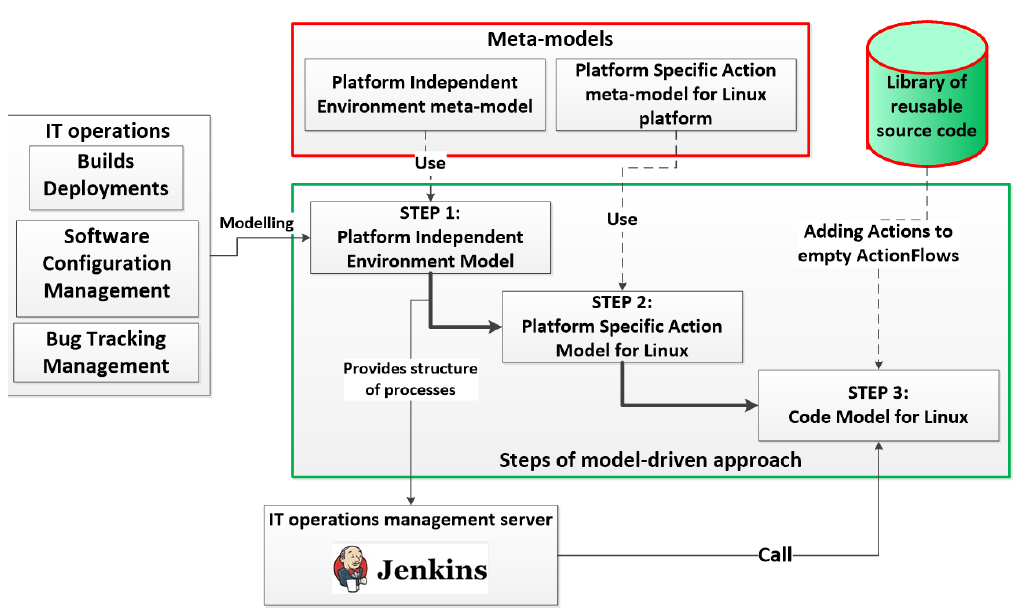
Fig. 6. Model-driven approach to generate source code for